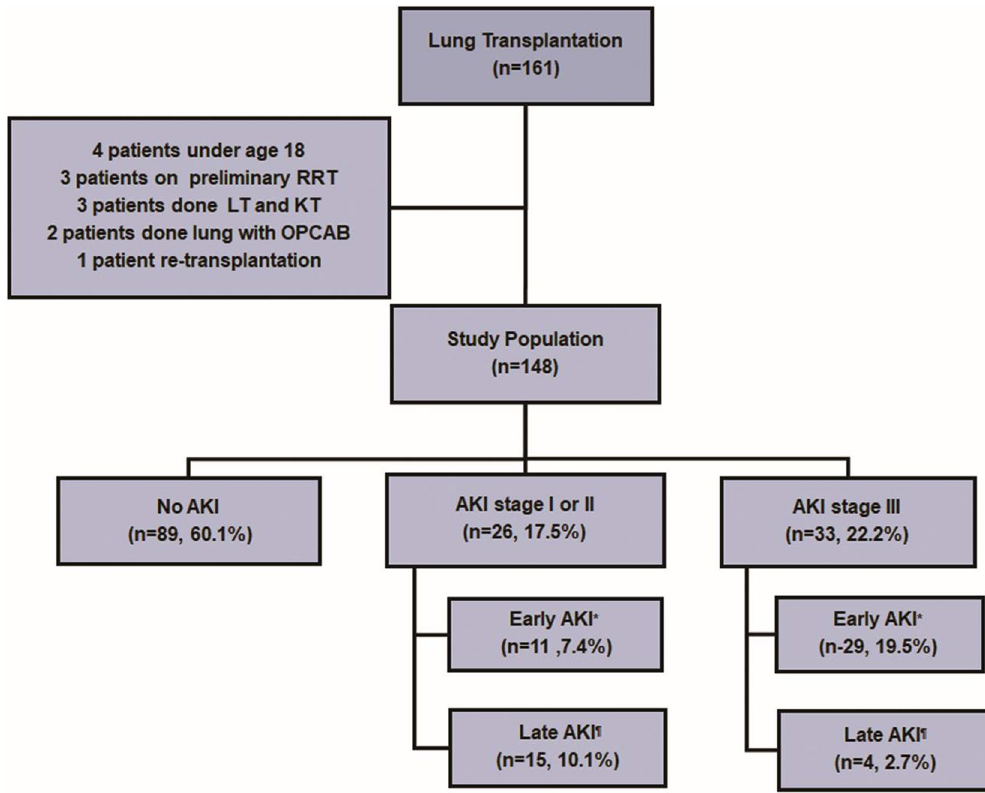
Figure 1. Study population and incidence of acute kidney injury of lung transplant recipients . 39.9% recipients developed acute kidney injury after lung transplantation within 1 month. *Early AKI, acute kidney injury within 1 week; ¶ late AKI, acute kidney injury after 1 week but within 1 month; RRT renal replacement therapy, LT lung transplantation, KT kidney transplantation, OPCAB off-pump coronary artery bypass, AKI acute kidney